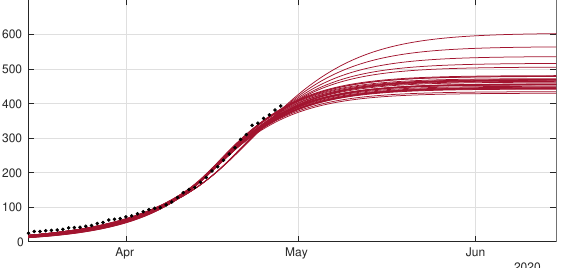
Figure 9. Daily number of cases. We plot the daily data (black dots) with DR ( t ) (blue curve). We fix f = 0.8, 1/ η = 7 days and 1/ ν = 7 and we apply the method described in Liu et al. [29]. The best fit is d 1 = 2 April, d 2 = 5 April, N = 27 April, µ = 0.6, χ 1 = 179, χ 2 = 0.085, χ 3 = 1 and t 0 = 13 January.